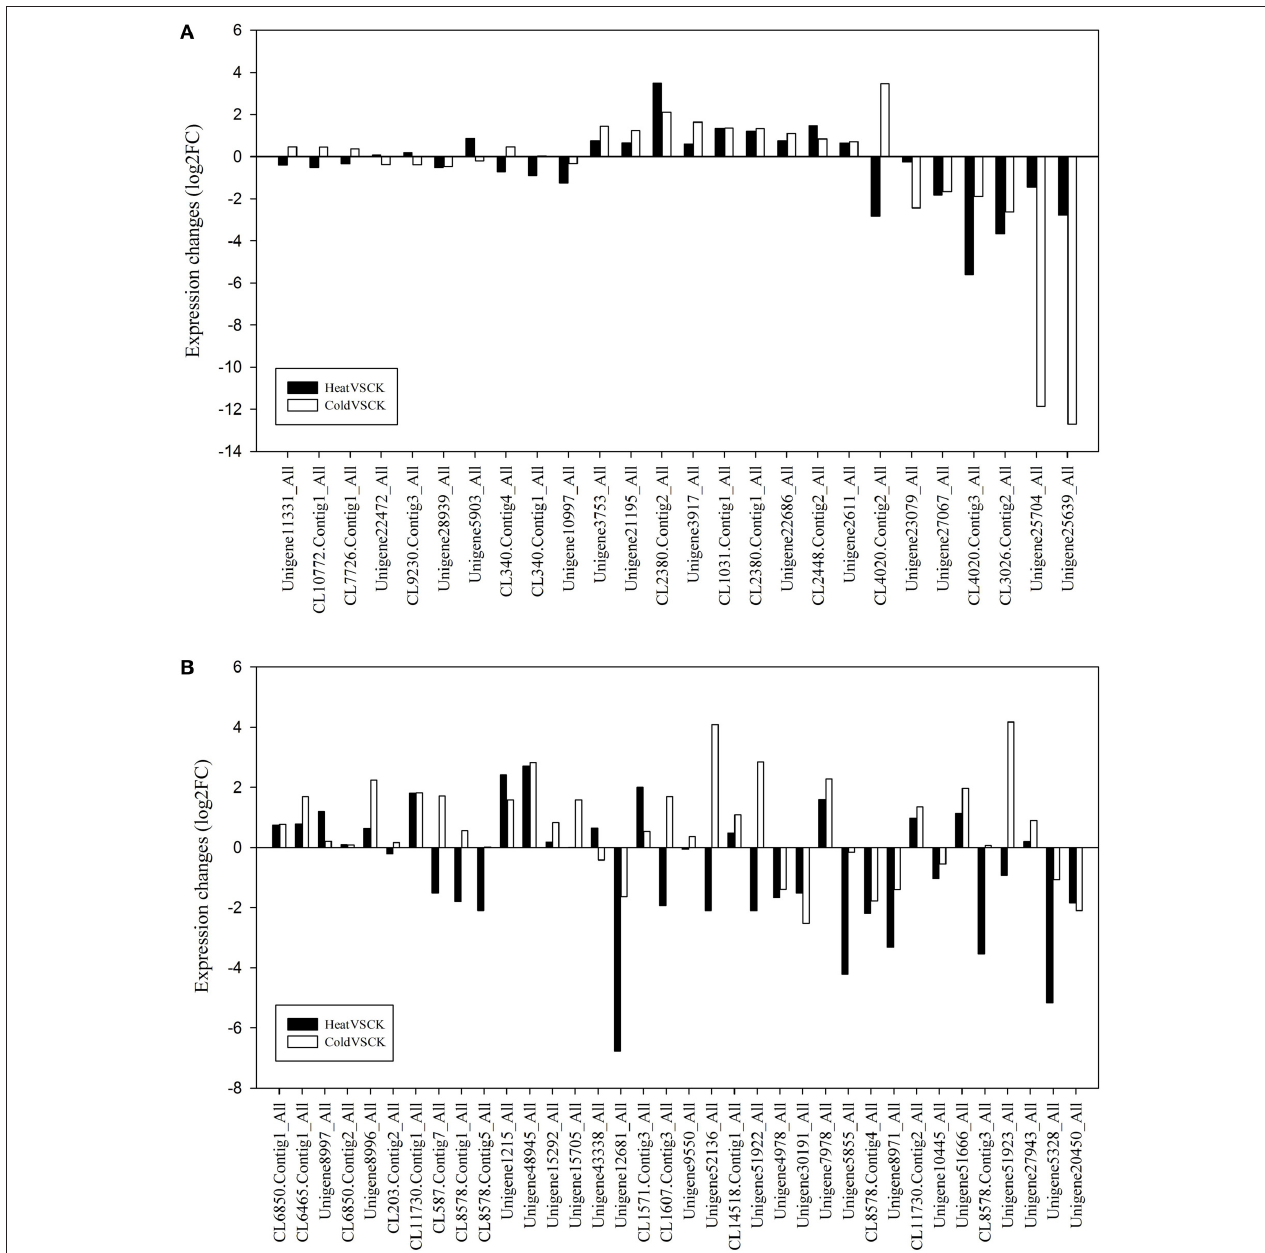
FIGURE 5 | Expression of P450 Transcripts Involved in Flavonoid Metabolism. P450 transcripts involved in flavonoid metabolism in (A) perennial ryegrass and (B) tall